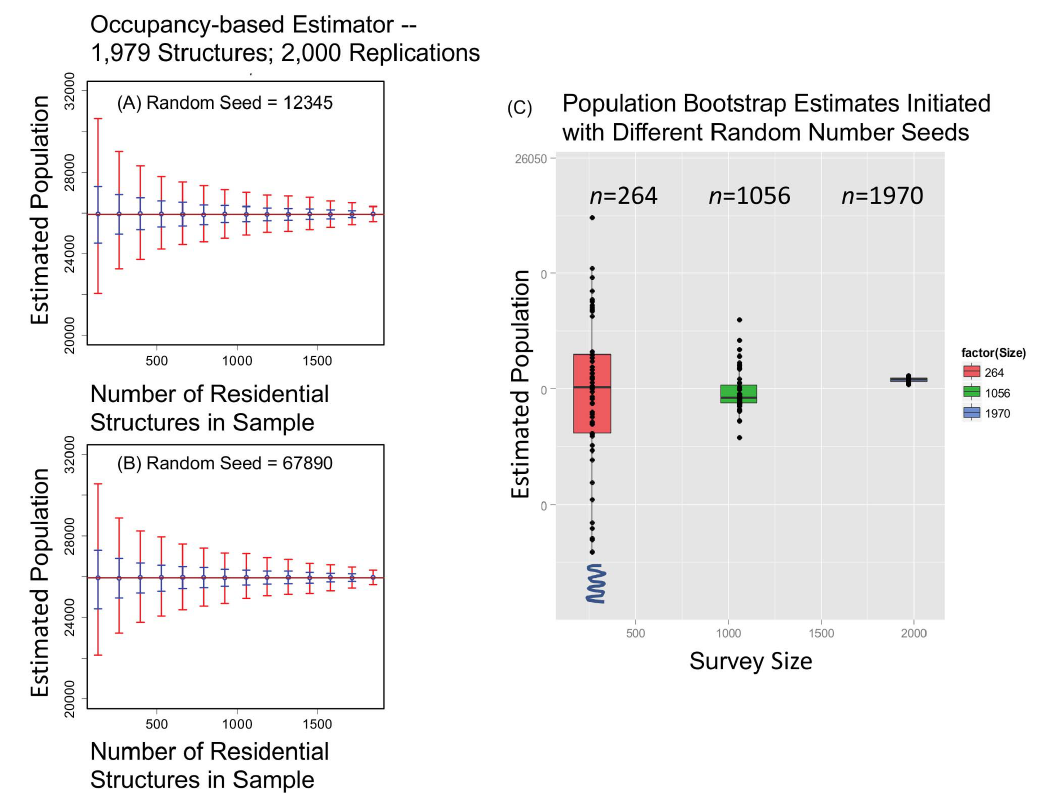
Figure 4. Occupancy-based bootstrap population estimations parameterized by sample size and random number seed. Results for (A) random number seed =12345 and (B) random number seed =67890. In both panels, the brown line is the total population count P ~ 25,954, the number of individuals counted in the 1,979 residences surveyed for DS01 . The 0.50 CIs is shown in blue and the 0.95 CI in red. (C) A quartile boxplot shows the variation in the population bootstrap estimates ^ PP for 25 replicate samples initiated with different random number seeds.